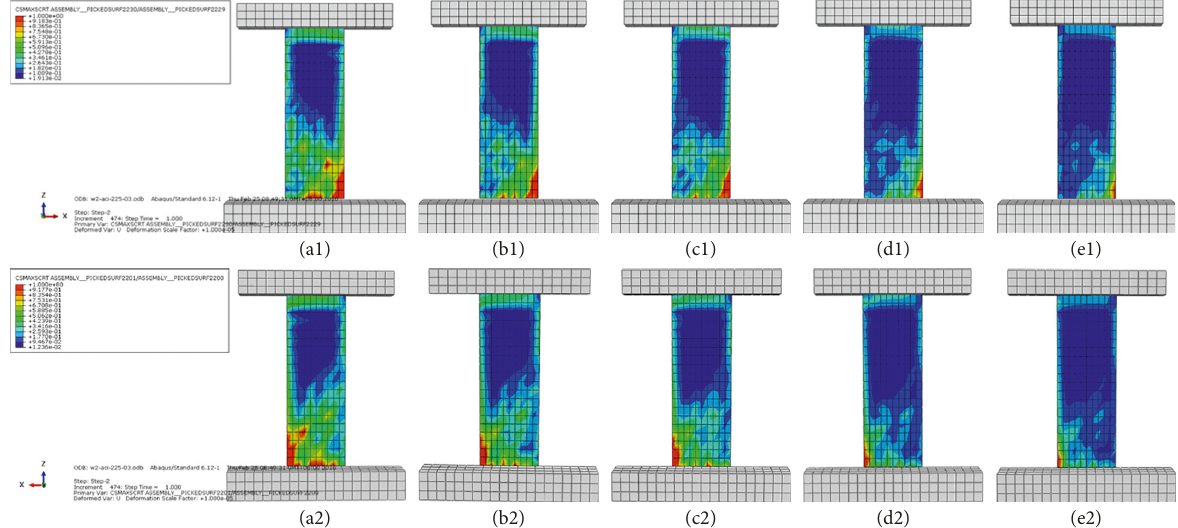
Figure 20: Maximum traction damage initiation criterion index CSMAXSCR of W2 under 0.3 axial compression